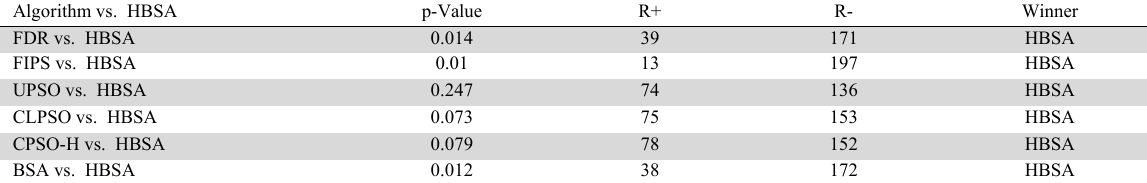
Multi-problem based statistical pairwise comparison of comparison algorithms and HBSA ( α = 0.05) Algorithm vs. HBSA p-Value R+ R- Winner FDR vs. HBSA 0.014 HBSA FIPS vs. HBSA UPSO vs. HBSA CPSO-H vs.